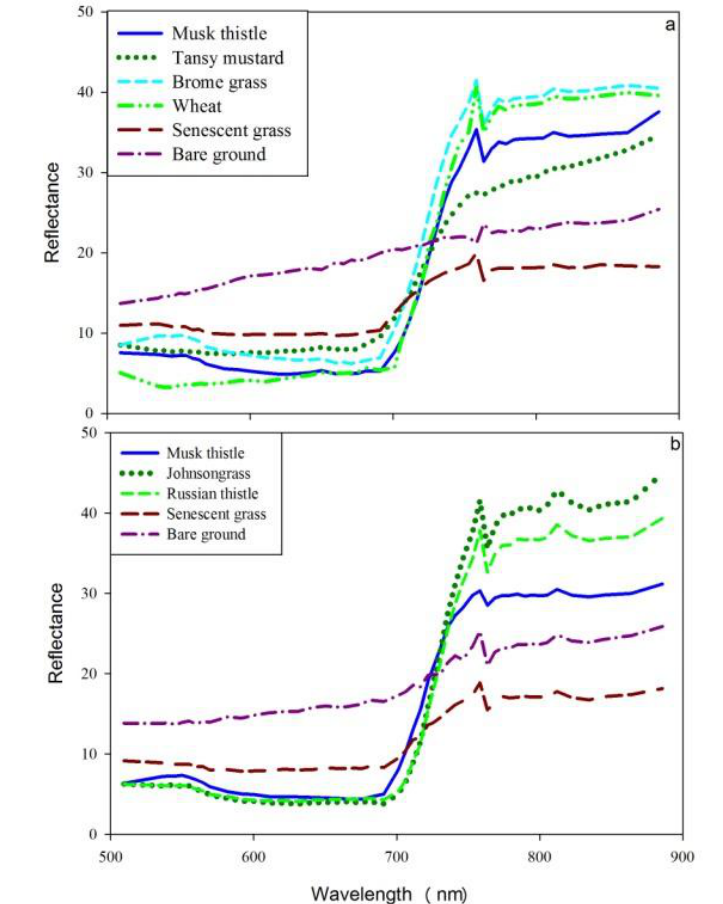
Figure 2. Spectral profile of training samples for musk thistle (N = 200), tansy mustard (N = 91), brome grass (N = 30), wheat (N = 200), senescent grass (N = 35) and bare ground (N = 200) in April ( a ) and musk thistle (N = 200), Russian thistle (N = 72), Johnsongrass (N = 84), senescent grass (N = 35) and bare ground (N = 200) in June ( b )